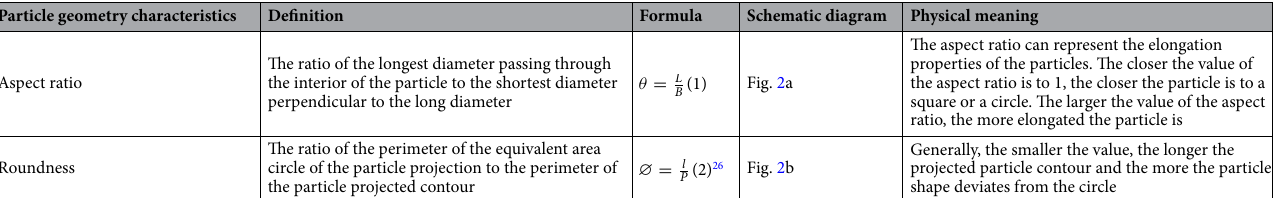
The aspect ratio can represent the elongation properties of the particles. The closer the value of the aspect ratio is to 1, the closer the particle is to a Fig. 2a square or a circle. The larger the value of the aspect ratio, the more elongated the particle is ∅ = l P (2) 26 Fig. 2b